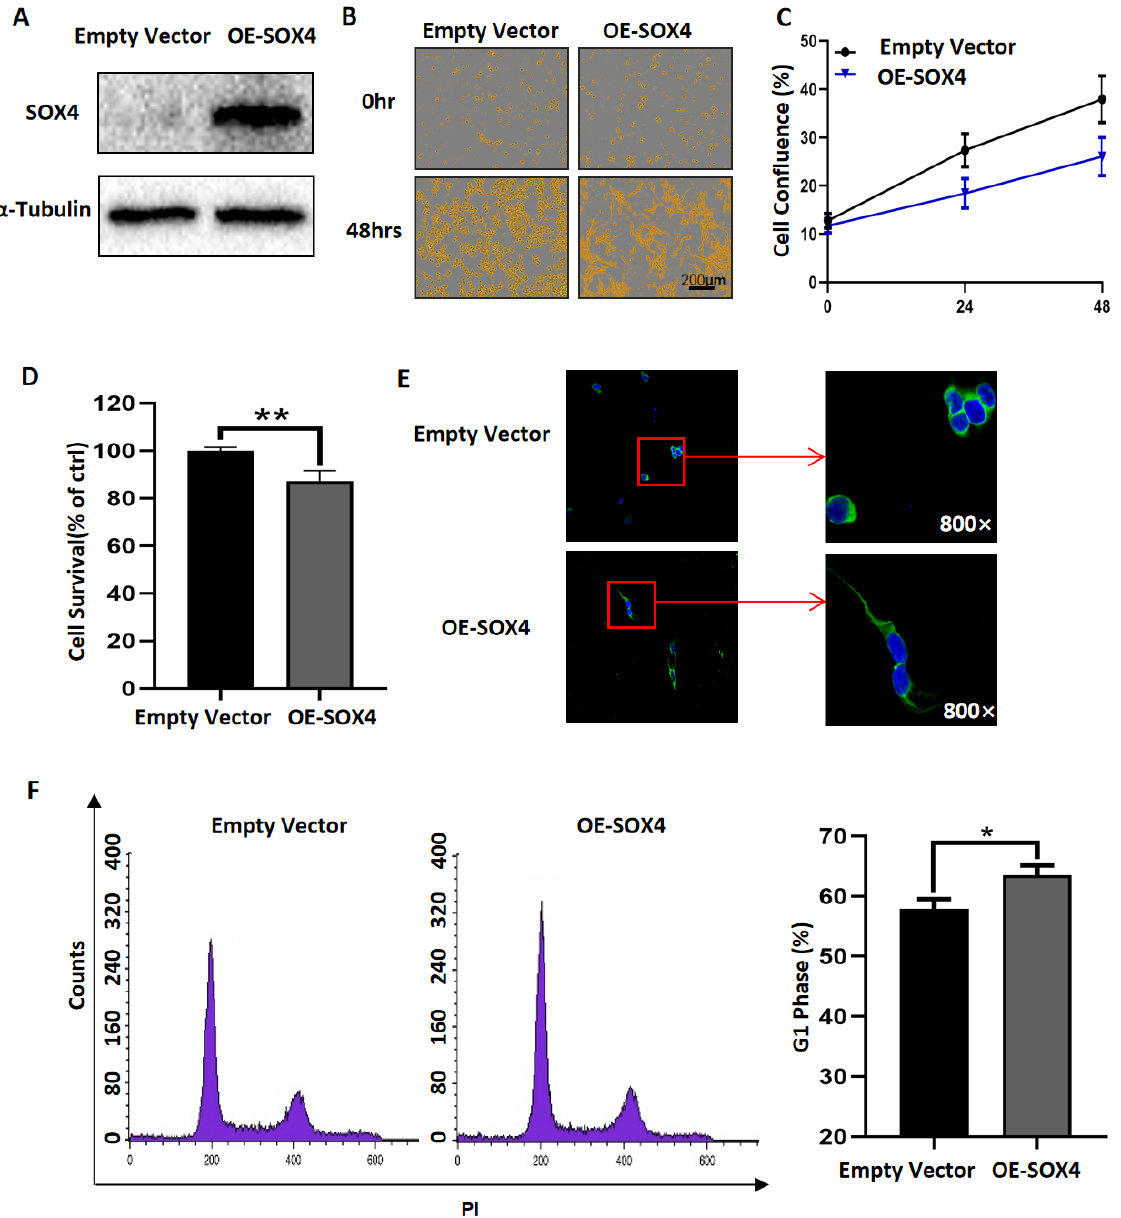
Figure 4. Overexpression of SOX4 has the potential to induce the differentiation of NB cells. ( A ) The expression of SOX4 in NGP cells was detected by Western blot 24 h after transfection with SOX4 overexpression plasmids. The cell confluence (% of the surface area of cells) or cell survival of SOX4- overexpressed NGP cells was detected by IncuCyte Zoom ( B , C ) or CCK8 assay ( D ). Empty vector vs. OE-SOX4, ** p < 0.01. ( E ) ICC staining was performed to show the morphological changes in NB cells 48 h after overexpressing SOX4. ( F ) Cell cycle analysis was performed 48 h after overexpressing SOX4, and the percentage of cells in G1 phase was analyzed. Empty vector VS. OE-SOX4, * p < 0.05. The uncropped Western blots have been shown in Figure S4.